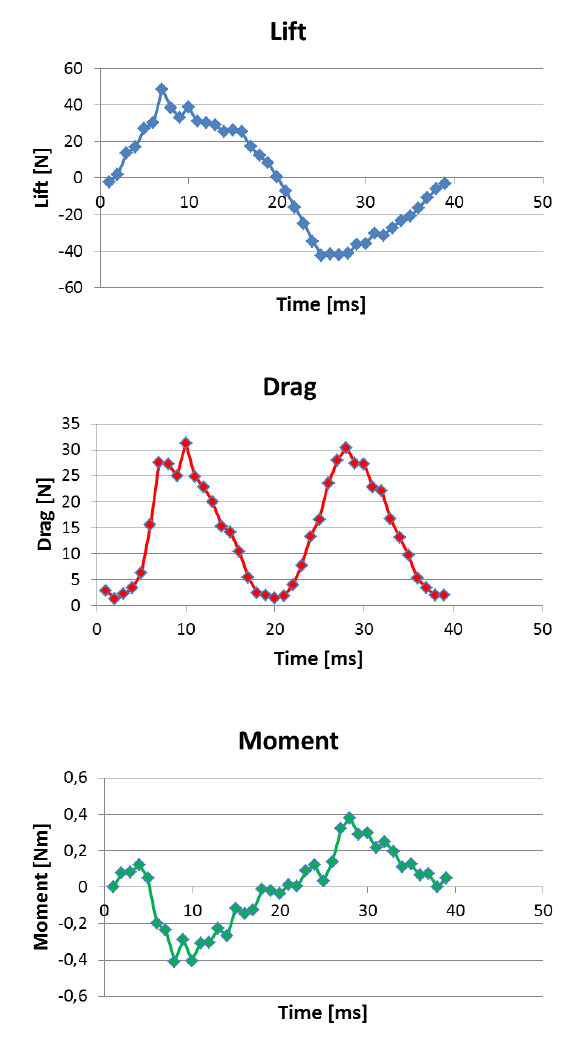
Fig. 11. Total forces: lift, drag and moment for Ma = 0.28.